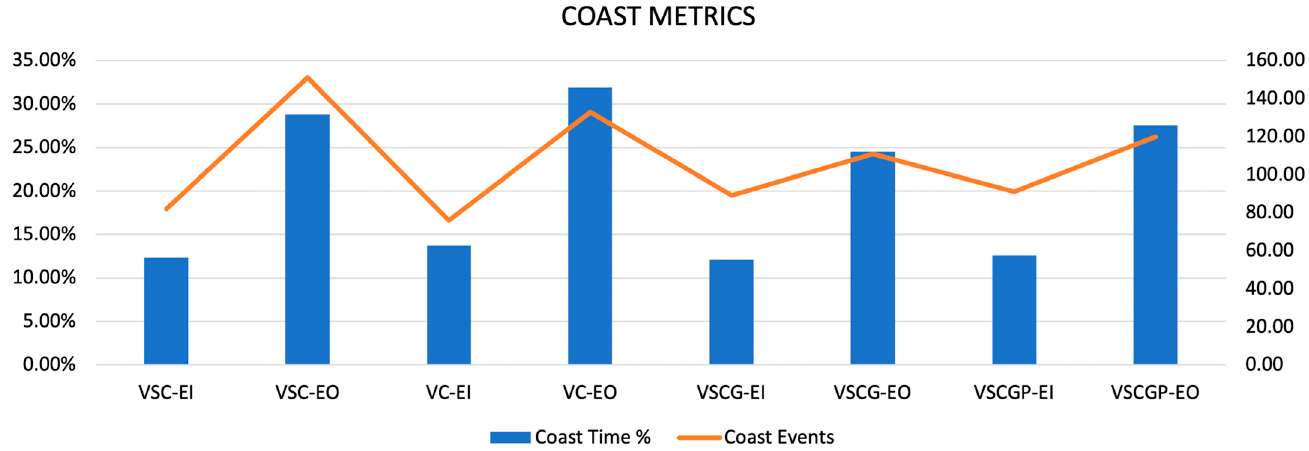
Figure 12. Coast metrics for all combination of problems with coast formulation. The bars show the % time in coast for each problem and the plot shows the number of coast events.